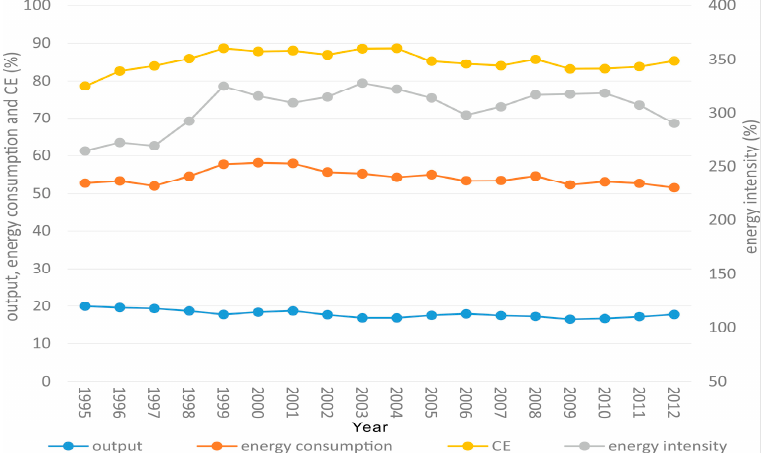
Figure 7. Proportions of the transport sector in tertiary industry of Guangdong, weighted by output, energy consumption, CE and energy intensity.